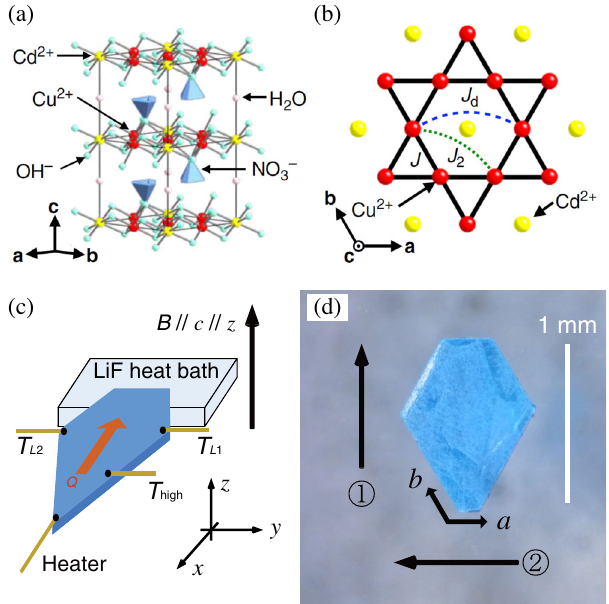
FIG. 1. (a) Crystal structure and (b) top view of a kagome layer of Cd-K [48]. The magnetic interactions between nearest- neighbor, next-nearest-neighbor, and diagonal Cu 2 þ spins are denoted by J (solid black line), J 2 (dotted line), and J line), respectively. (c) Schematic illustration of κ measurements. A heater and three thermometers ( T and T ) are attached to the sample fixed on the LiF heat bath. A L 2 heat current Q is applied within the kagome layer, and a magnetic field B is applied along the c axis. (d) A typical crystal of Cd-K. The direction of the heat current for samples 1, 2, and 3-1 (3-2) is shown by arrow 1